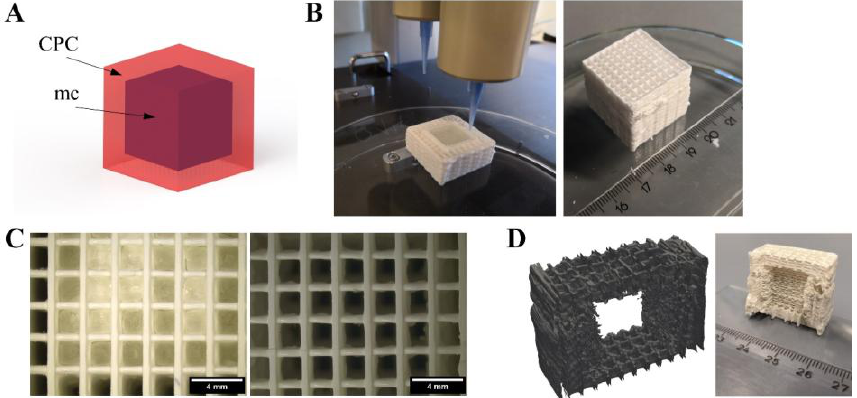
Figure 6. Generation of an inner cavity inside a CPC scaffold. ( A ) Principle of the CPC (red) structure with an inner cavity, filled with support material (mc, purple). ( B ) Fabrication and post-plotting appearance of the cubic structure with 410 μm needles. ( C ) After plotting (left), pores in z -direction of the CPC part are not interconnected but closed by mc at the interface of both materials. After methylcellulose vanished (right), the pores were clearly open and interconnected (scale bars 4 mm). ( D ) Virtual cut of micro computed tomography of the cube and photograph of the cut cube after mc vanished, revealing the cubical-shaped cavity inside the macroporous CPC structure. More images are provided in Supplementary Figure S1.